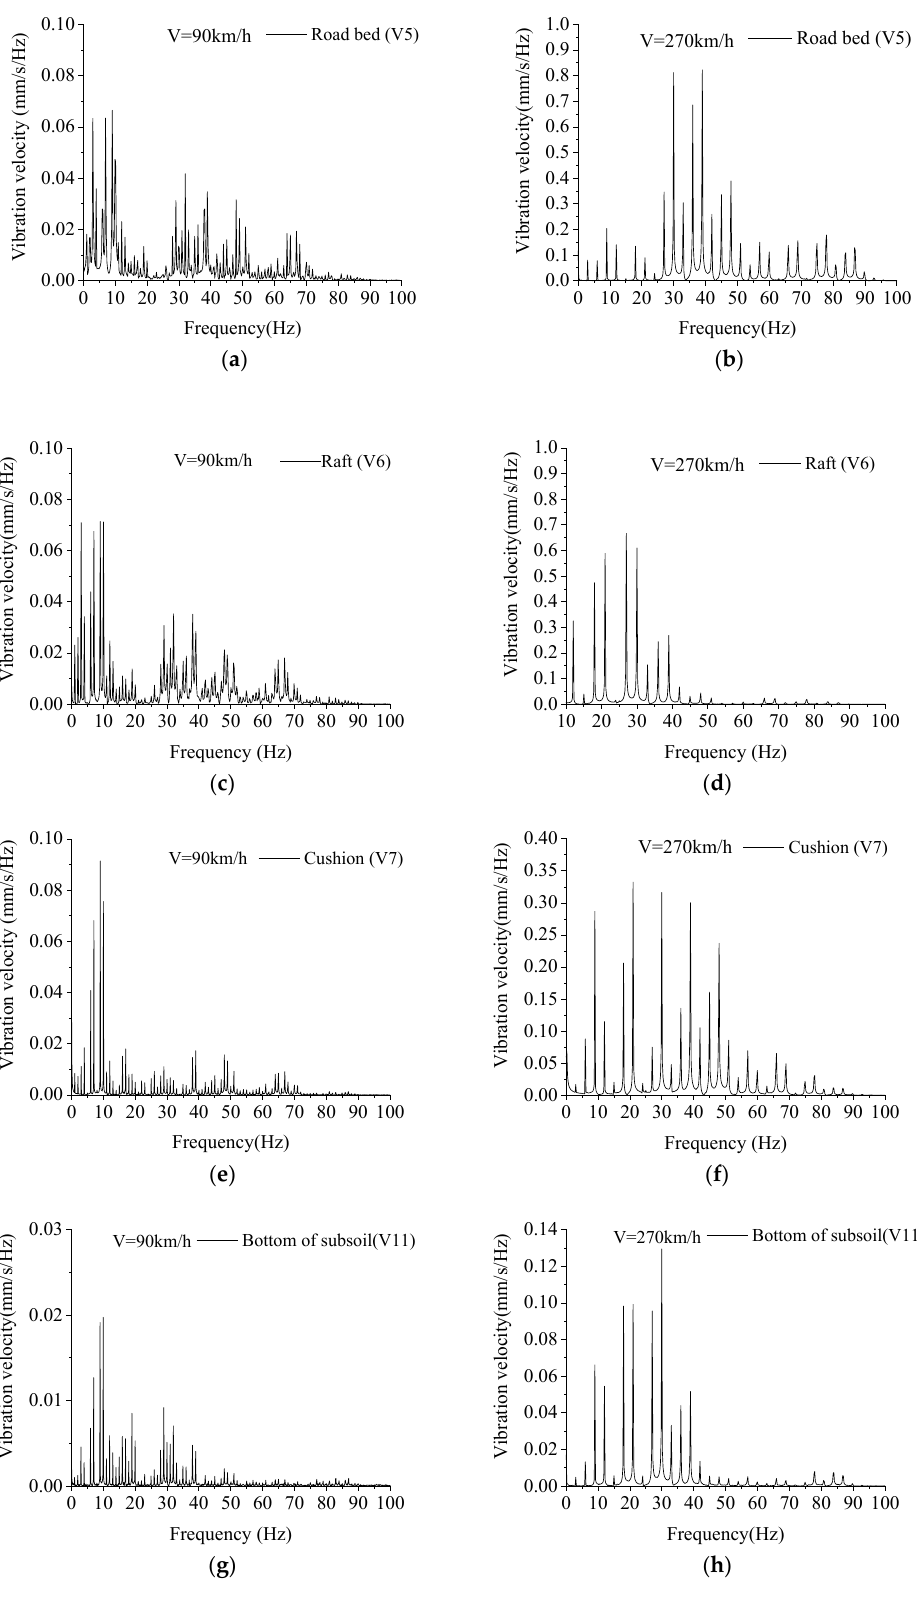
Figure 10. Frequency spectrum analysis of vibration velocities at different locations of a track embankment pile–raft foundation. ( a ) Roadbed (V5, v = 90 km/h), ( b ) Roadbed (V5, v = 270 km/h), ( c ) Raft (V6, v = 90 km/h), ( d ) Raft (V6, v = 270 km/h), ( e ) Cushion (V7, v = 90 km/h), ( f ) Cushion (V7, v = 270 km/h), ( g ) Bottom of subsoil (V11, v = 90 km/h), ( h ) Bottom of subsoil (V11, v = 270 km/h).